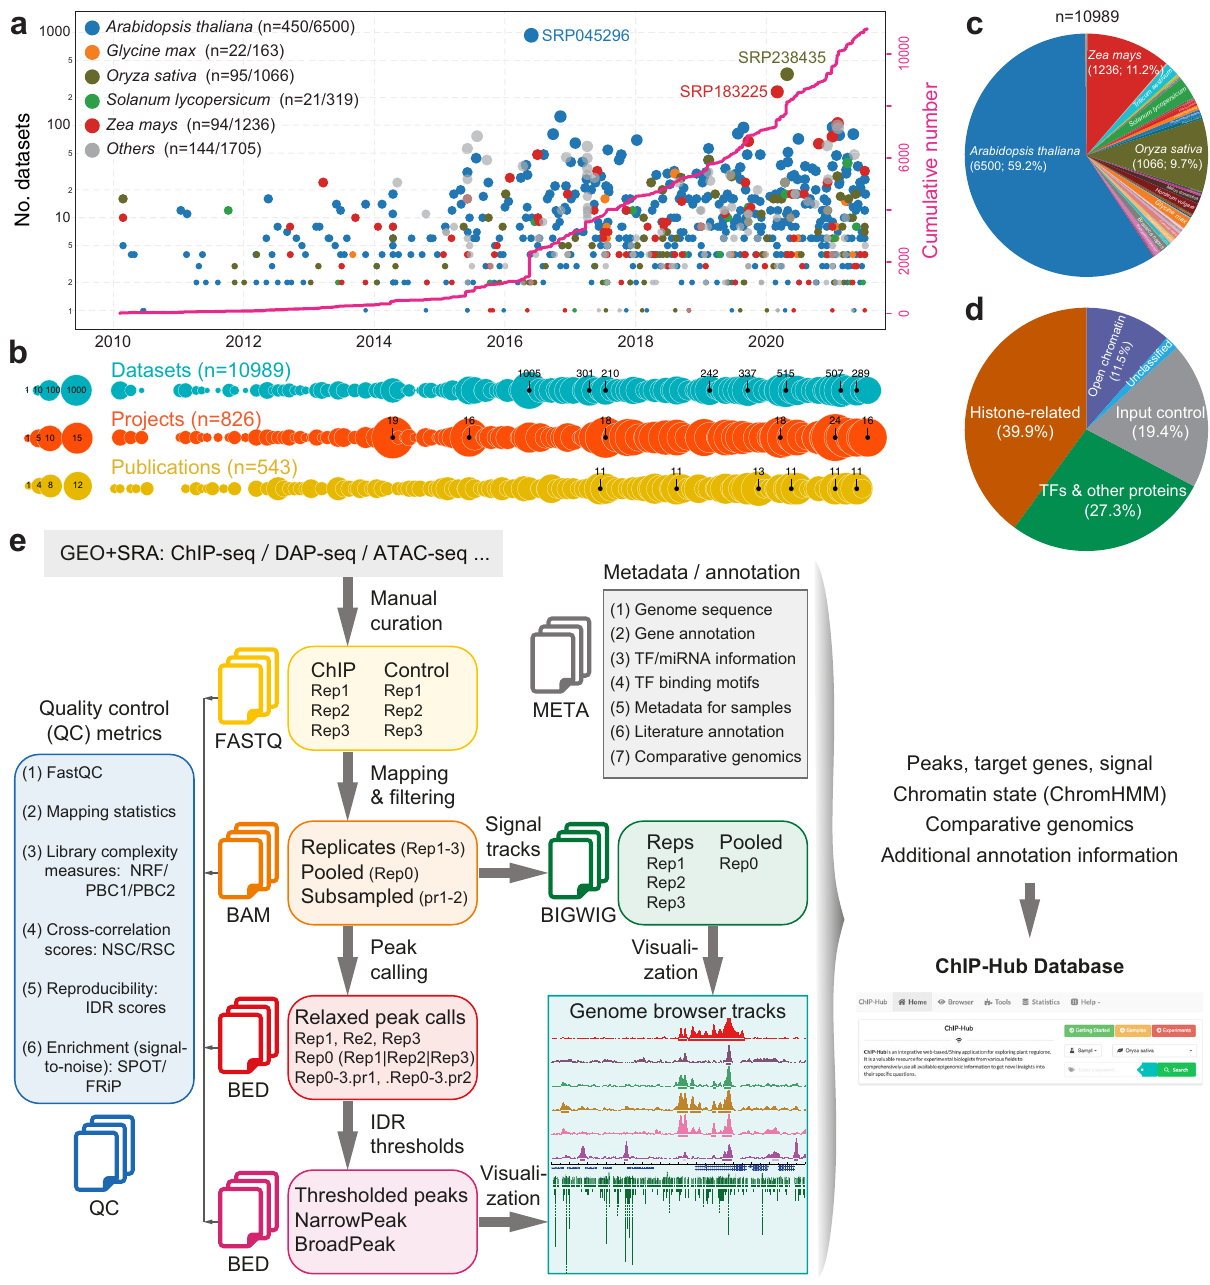
Fig. 1 The ChIP-Hub platform: data collection and the computational pipeline. a Explosive generation of regulome and epigenome data in plants. The scatter plot (top) shows the number of datasets over time, as colored by the top representative plant species. Each data point represents one SRA BioProject. The cumulative number is also shown (in pink). b Timeline plots showing the overview of the number of datasets, publications and BioProjects over time. c Pie chart showing the distribution of datasets by plant species. d Pie chart showing the distribution of datasets by sample categories. e A standardized, semi-automatic analysis pipeline developed for regulome and epigenome experiments. We adapted the working standards provided by the ENCODE consortium 10 to set up the computational pipeline, including read mapping, peak calling and subsequent statistical treatment of replicates. The resulting data are further integrated by ChromHMM 58 for each plant species. All the metadata as well as analyzed data are bundled in our Shiny application ChIP-Hub for visualization and genomes with more than 20 distinct experiments, the number of (12.6%) and human (~20%) genomes 19,20 . However, the propor- identi fi ed open chromatin regions, TF binding events or histone- tion may be far underestimated for most plant genomes since modi fi ed genomic locations varies from 0.21 million ( Chlamydo- many regulators have not yet been investigated. Of note, about monas reinhardtii ; experiments n = 32) to 21.4 million ( Arabi- 3500 individual experiments have been generated in Arabidopsis dopsis thaliana ; n = 3479); the fraction of genome associated with (Fig. 2b), resulting in annotated genomic regions in terms of TF-bound and histone-modi fi ed regions shows an average of chromatin status or TF binding encompassing at least 82.1% of 22.0% (Fig. 2g), with comparable proportions found in the mouse the Arabidopsis genomic sequence in aggregate (Fig. 2g).